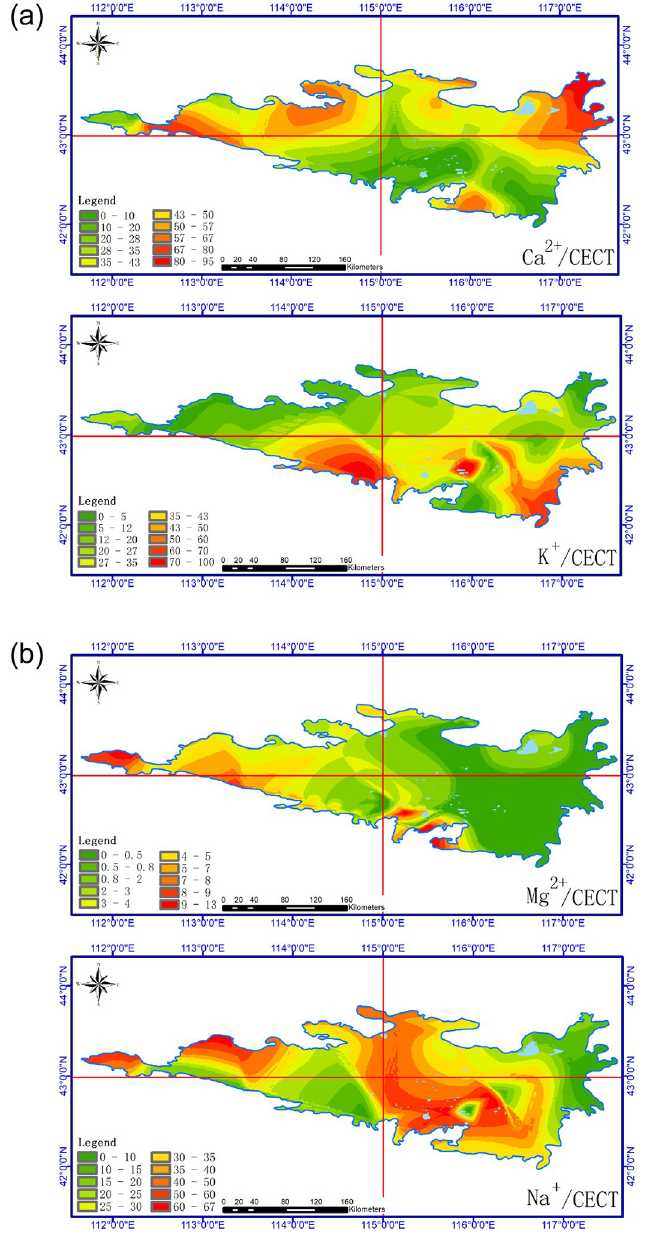
Fig 9. Spatial distribution characteristics of effective exchangeable base ions in soil. (Cartographic software: Arcgis10.5).